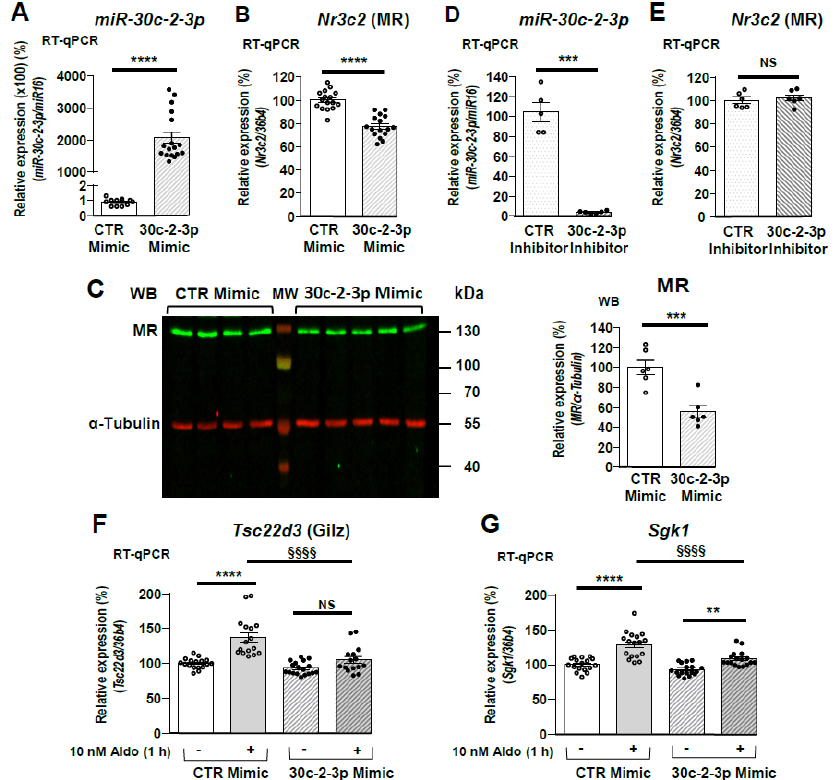
Figure 5. miR-30c-2-3p overexpression decreases MR expression in renal KC3AC1 cells and com- promises MR-mediated target gene expression. Renal KC3AC1 cells were transfected with 10 nM Mimics or 10 nM negative Control Mimics (CTR mimic). ( A ) Specific overexpression of miR-30c-2-3p in renal KC3AC1 cells was confirmed by RT-qPCR. ( B ) Quantitative RT-qPCR of endogenous Nr3c2 (MR) expression, analyzed 18 h after transfection. Data are means ± SEM from three independent experiments performed in 4–6 replicates ( n = 12–18). NS = not significant, **** p < 0.0001 compared to CTR Mimics, arbitrarily set at 100%. ( C ) Western blot analysis of MR expression, 48 h following transfection of CTR Mimics or 30c-2-3p Mimics (left panel) and quantification of the corresponding signals (right panel) in which MR expression with CTR Mimics was arbitrarily set at 100%. Data are means ± SEMs ( n = 6). ( D , E ) Renal KC3AC1 cells were transfected with 10 nM Inhibitors or negative Control Inhibitors (CTR inhibitor). ( D ) Specific overexpression of miR-30c-2-3p in renal KC3AC1 cells was confirmed by RT-qPCR. ( E ) Quantitative RT-qPCR of endogenous Nr3c2 (MR) expression, analyzed 18 h after transfection. Data are means ± SEMs ( n = 6). NS = not significant, *** p < 0.001, **** p < 0.0001 compared to CTR inhibitor, arbitrarily set at 100%. ( F , G ) Overexpression of miR-30c-2-3p prevented aldosterone-induced expression of Tsc22d3 (Gilz) ( F ) or of Sgk1 ( G ) in renal KC3AC1 cells. KC3AC1 cells were deprived for 24 h in minimal medium then cells were transfected with 10 nM CTR Mimics or 10 nM 30c-2-3p Mimics. Eighteen hours later, cells were stimulated with 10 nM Aldosterone for 1 h then Tsc22d3 (Gilz) or Sgk1 expression was measured by RT-qPCR. Data are means ± SEM from three independent experiments performed in six replicates ( n = 18). NS = not significant, ** p < 0.01, **** p < 0.0001 compared to condition without aldosterone stimulation. §§§§ p < 0.0001 between the 2 conditions indicated by